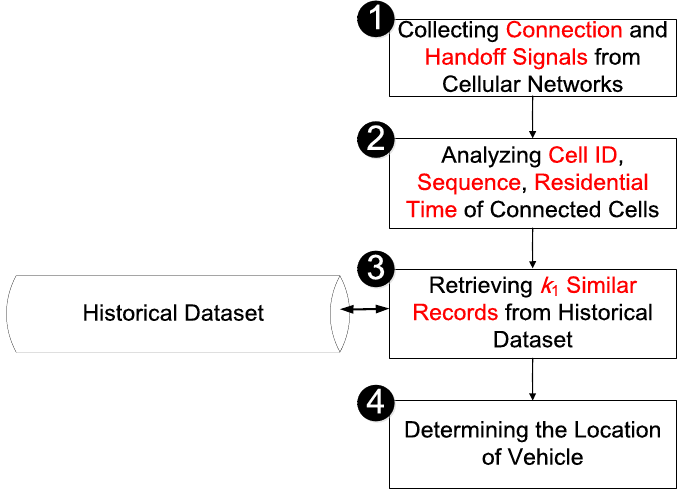
Figure 3. The steps of vehicle positioning method.